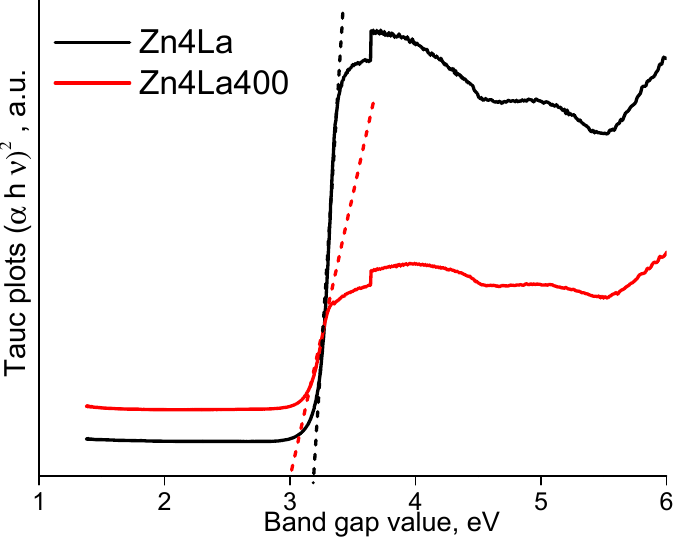
Figure 8. Tauc plots for the Zn4La and Zn4La 400 samples.